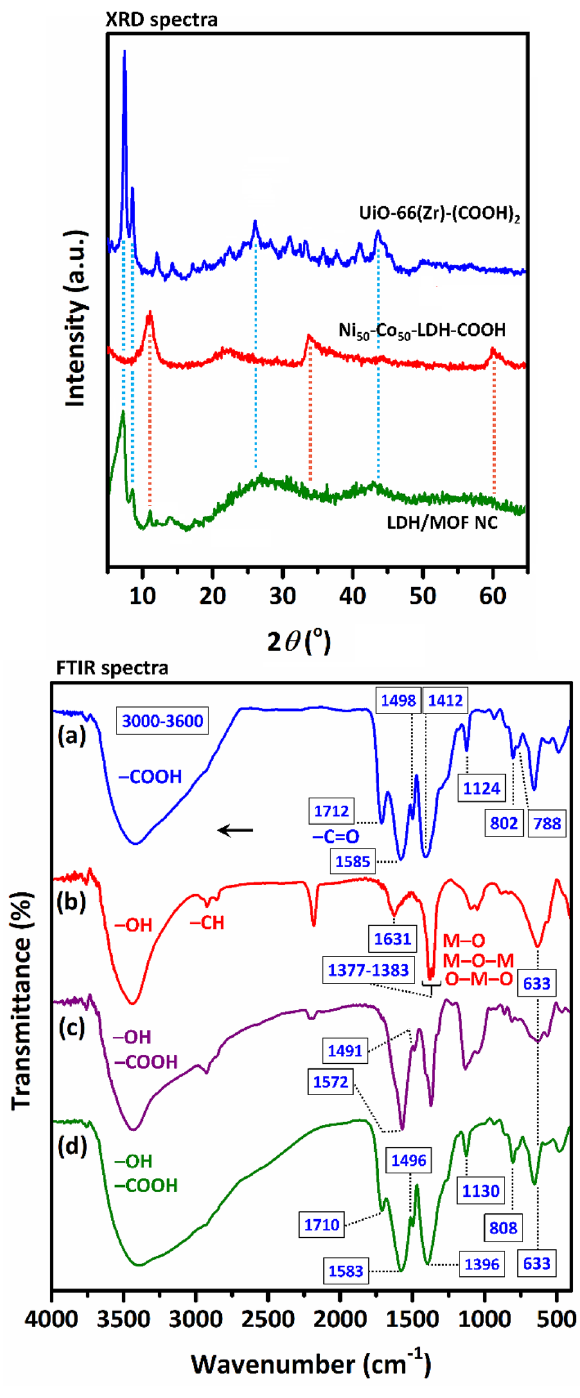
Figure 1. XRD and FT-IR spectra of the samples: ( a ) pure UiO-66(Zr)-(COOH) 2 (MOF), ( b ) pure Ni 50 Co 50 - LDH, ( c )